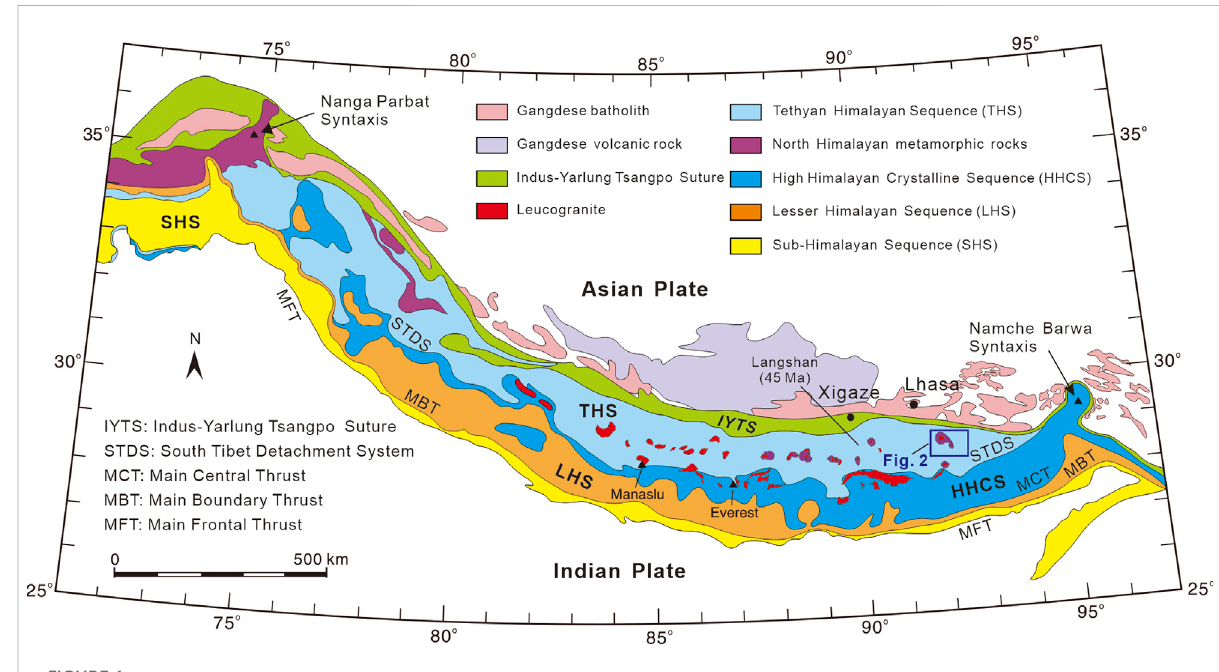
FIGURE 1 Simpli fi edgeologicalmapofHimalaya,showingthesubdivisionofthisorogenanddistributionofleucogranites(modi fi edafterYinandHarrison (2000), Yin (2006), Pan et al. (2012) and Kohn